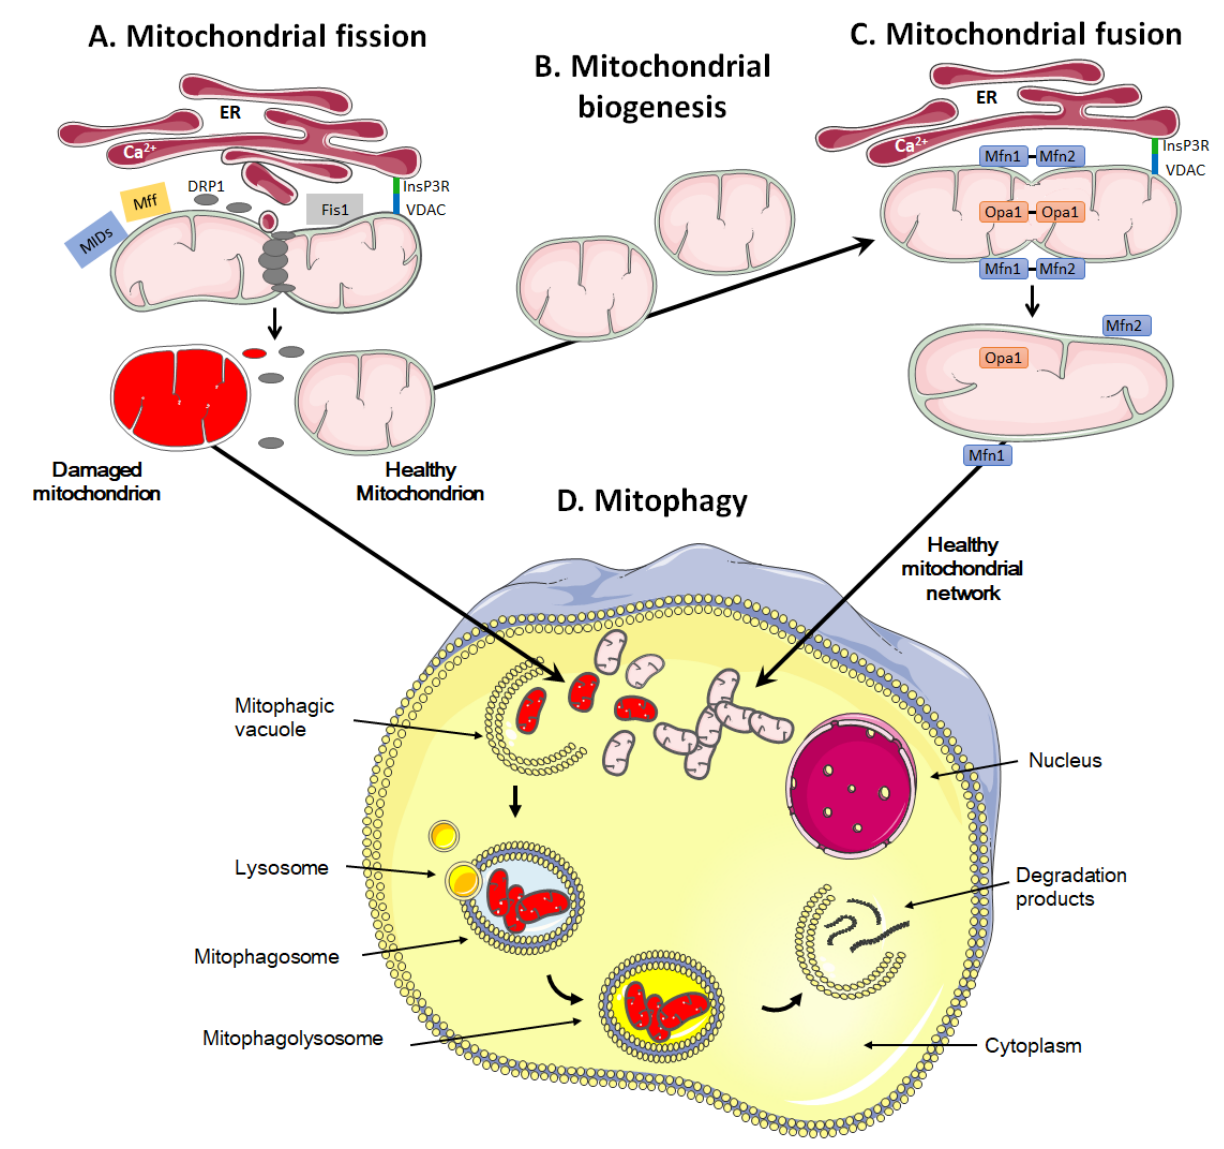
FIGURE 3: A high mitochondrial turnover rate is characteristic of many cancer cells. Mitochondrial quality control involves fission and mitophagy to eliminate defective mitochondria, whereas repopulation and functionalization depends on mitochondrial biogenesis and fusion. (A) During fission, the mitochondrion is marked and anchored by the endoplasmic reticulum (ER), notably through the binding of inositol 1,4,5-trisphosphate receptor (InsP3R) at the ER surface to voltage-dependent anion channel (VDAC) at the mitochondrial surface. This leads to the recruitment of dynamin-related protein 1 (DRP1), mitochondrial receptor protein 1 (Fis1), mitochondrial fission factor (Mff) and mitochondrial dynamic proteins (MIDs), allowing oligomerization and constriction to yield two daughter mitochondria. (B) During mitochondrial biogenesis, a mitochondrion self-replicates. (C) During fusion, mitofusins Mfn1 and Mfn2 are located on the outer mitochondrial membrane, allowing the exchange of calcium for signaling and creating antiparallel connections between two fusing mitochondria. Optic atrophy 1 (Opa1) together with Mnf1 participate in the fusion of the inner mito- chondrial membrane. Fusion allows the formation of mitochondrial networks. (D) The mitophagic process consists in the engulfment of damaged mitochon dria in a vacuole, called ‘mitophagic vacuole’. The subsequent fusion of the mitophagosome with lysosomes, forming a mitophago lyso- some, allows the degradation of mitochondria in macromolecules that are delivered to the cytosol. Mitophagy can be non-selective or selective, using canonical and non-canonical pathways. It prevents the accumulation of damaged mitochondria that could harm or even kill the cell if apoptosis and/or the production of reactive oxygen species would